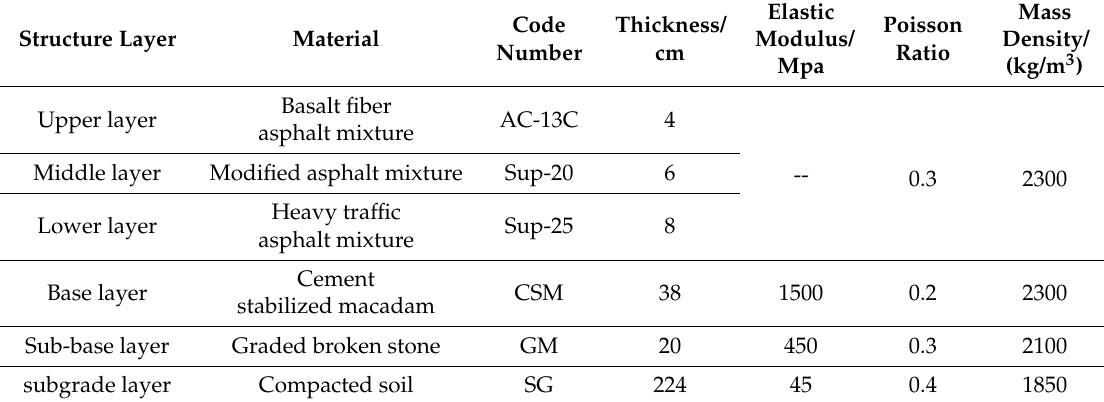
Figure 5. Layers of pavement. Table 1. Parameters of each layer.